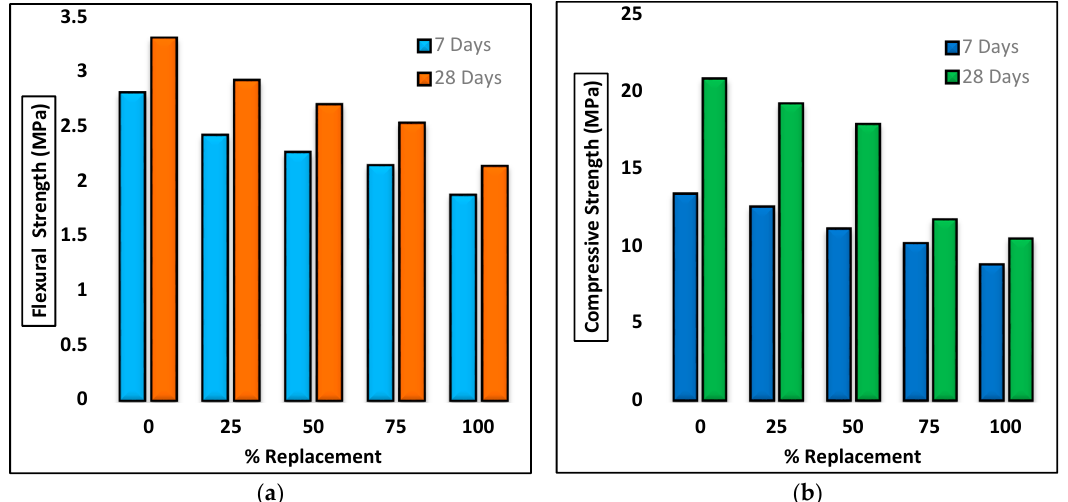
Figure 6. Destructive testing: ( a ) compressive strength at 7-days and 28-days curing, ( b ) flexural strength at 7-days and 28-days curing.